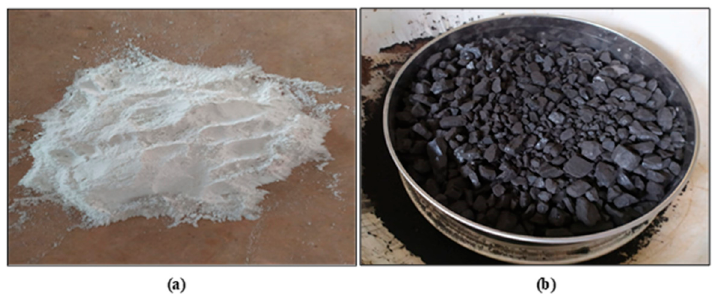
Figure 2. ( a ) Lime 0/1 mm. ( b ) Coal aggregates 0/40